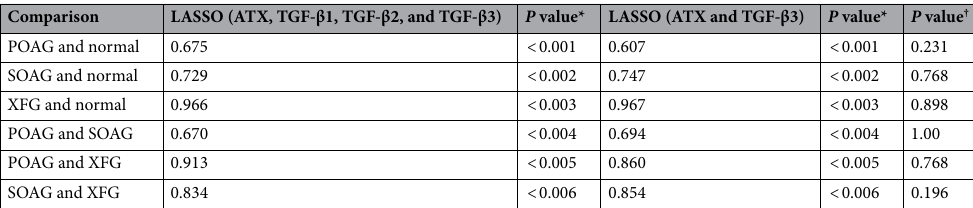
Table 2. AUC values for classifying each disease type. P values with * means the significance of the AUC value. P values with † shows the results of the comparisons of AUC values between LASSO (ATX, TGF-β1, TGF-β2, and TGF-β3) and LASSO (ATX and TGF-β3). AUC, area under the receiver operating characteristic curve; POAG, primary open-angle glaucoma; SOAG, secondary open-angle glaucoma; XFG: exfoliation glaucoma; LASSO, least absolute shrinkage and selection operator; ATX, autotaxin; TGF-β, transforming growth factor-beta.